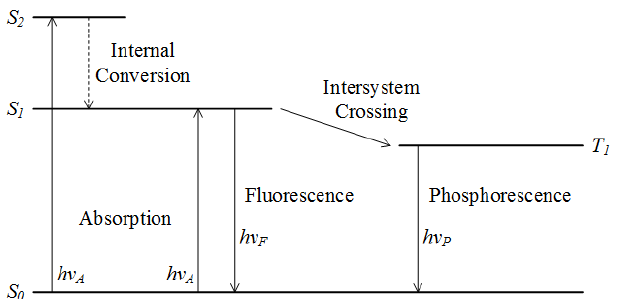
Figure 2. Jablonski diagram [17]. Reproduced with permission from A. Nawrocka, Advances in Agrophysical Research, Published by IntechOpen, 2013.